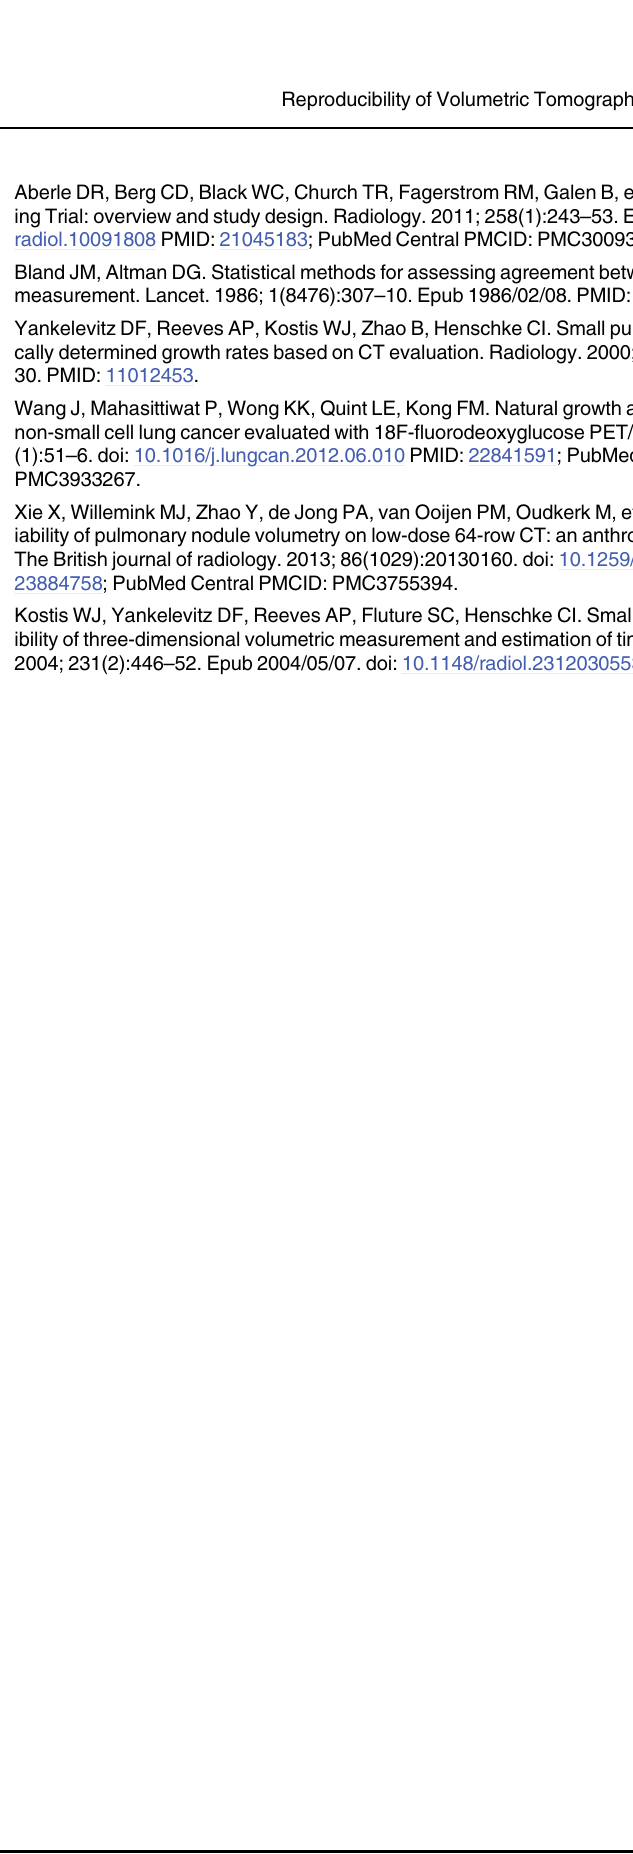
PLOS ONE | DOI:10.1371/journal.pone.0138144 September 17,